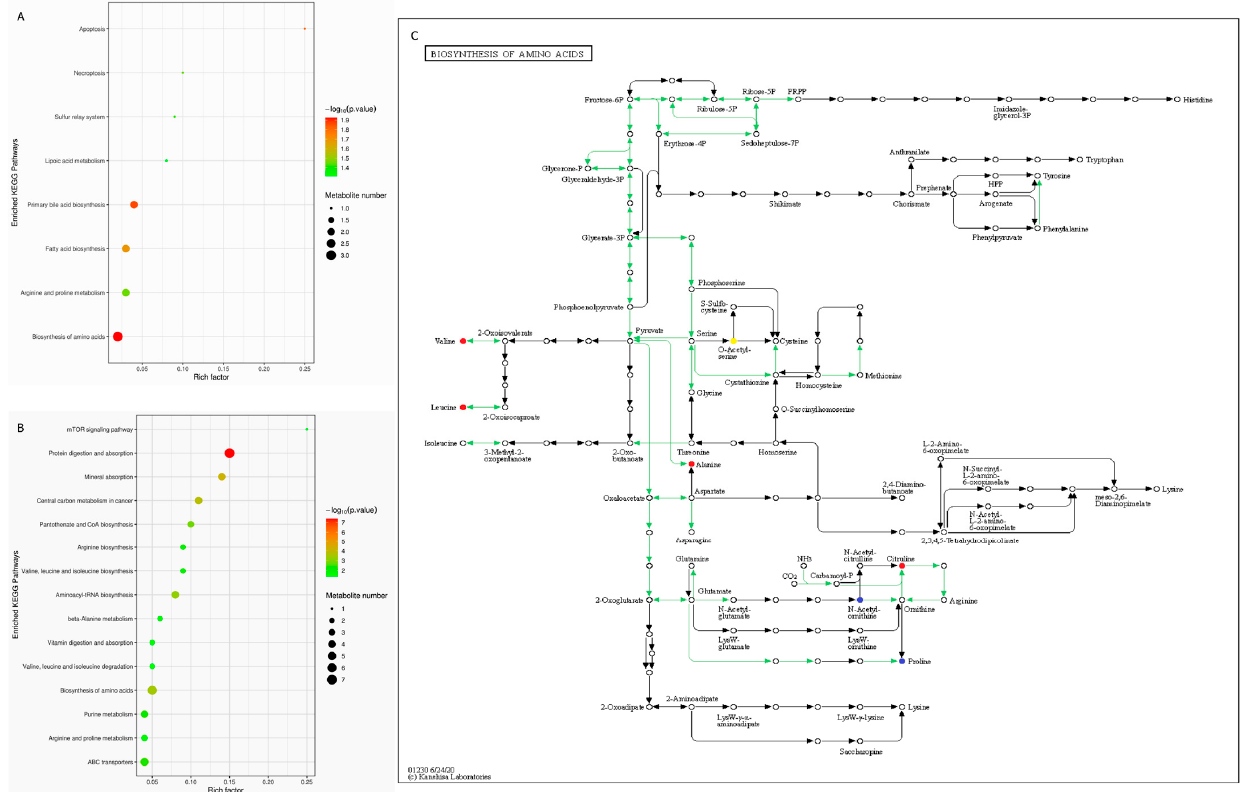
Figure 4. Enrichment analysis of the differentially abundant pathways between T2DM and Control groups ( A ), IGR and Control groups ( B ) ( p < 0.05). Amino acids biosynthesis pathways shared by T2DM and IGR macaques ( C ). The yellow points indicate differential metabolites in T2DM macaques; the red points indicate differential metabolites in IGR macaques; and the blue points indicate differential metabolites both in T2DM and IGR macaques; the green lines indicate the unique signaling pathways of macaques.